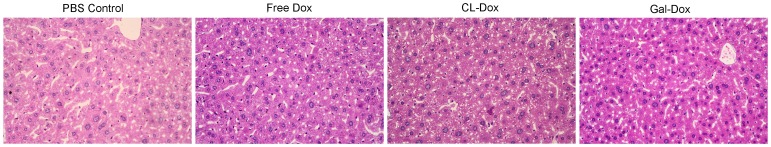
Microscopy images of H&E stained normal liver tissue slides.The normal liver tissues from groups treated with three drug formulations via spleen injection and PBS groups were collected and fixed using 10% formalin for 24 hrs at room, and then hematoxylin and eosin staining (H&E staining) was carried out. Magnification = 400×.